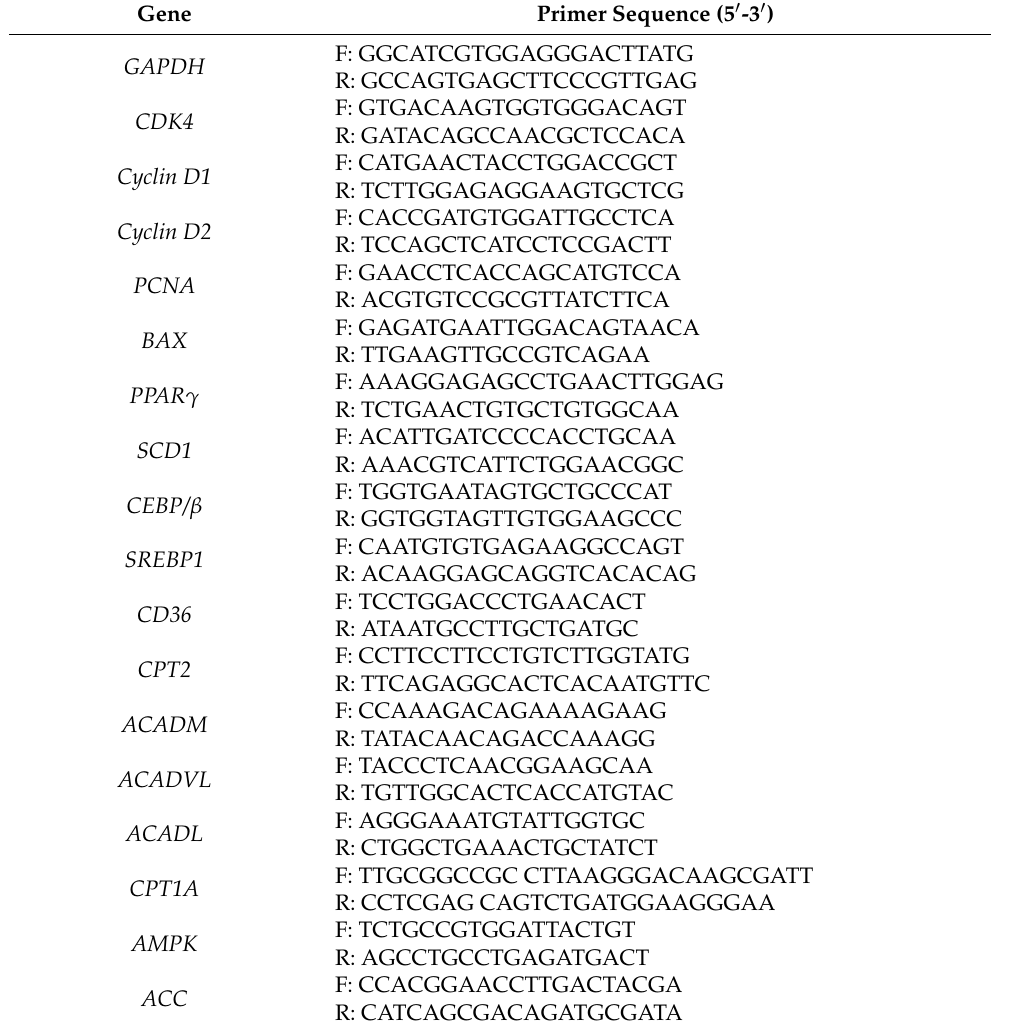
Table 4. Primer sequences of the